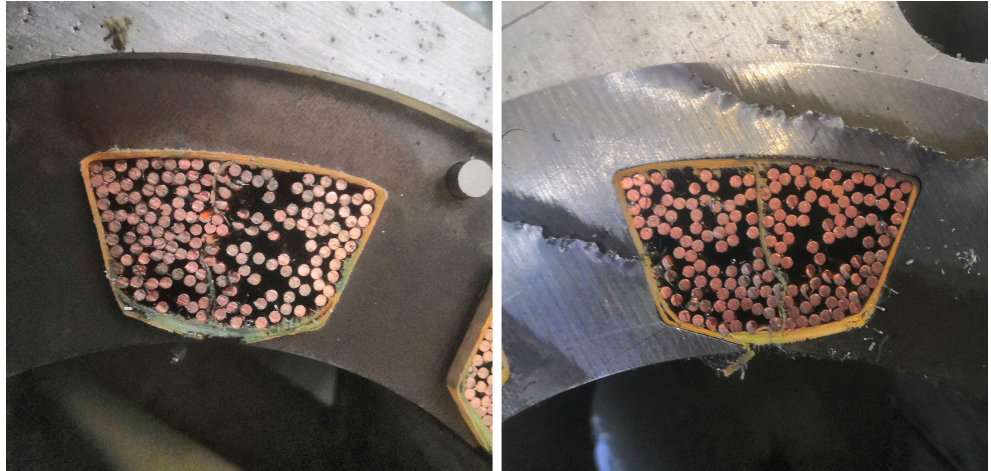
Figure 1. Stator slots in the cut synchronous